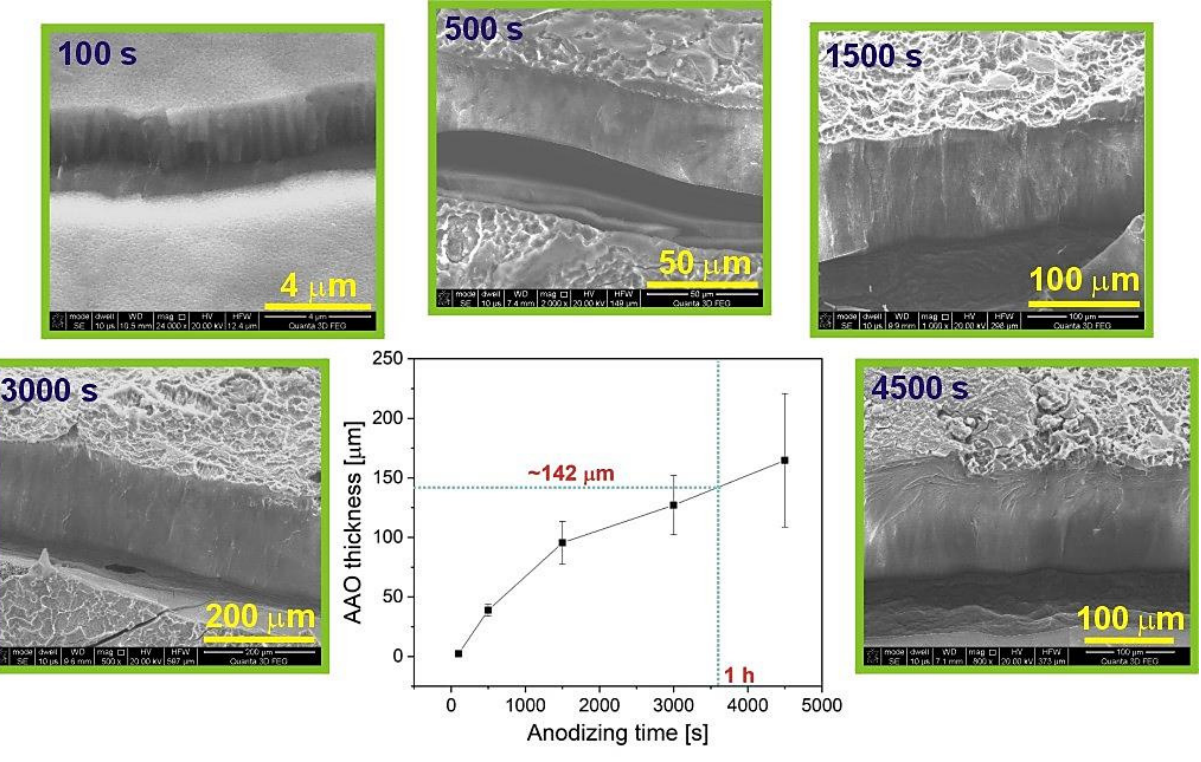
Figure 4. AAO thickness as a function of anodizing time; in the middle of the SEM images, the graph shows the dependence of the average AAO thickness on anodizing time. Table 2. Thickness of AAO obtained in various anodizing conditions (the acids are arranged according to their increasing pK a1